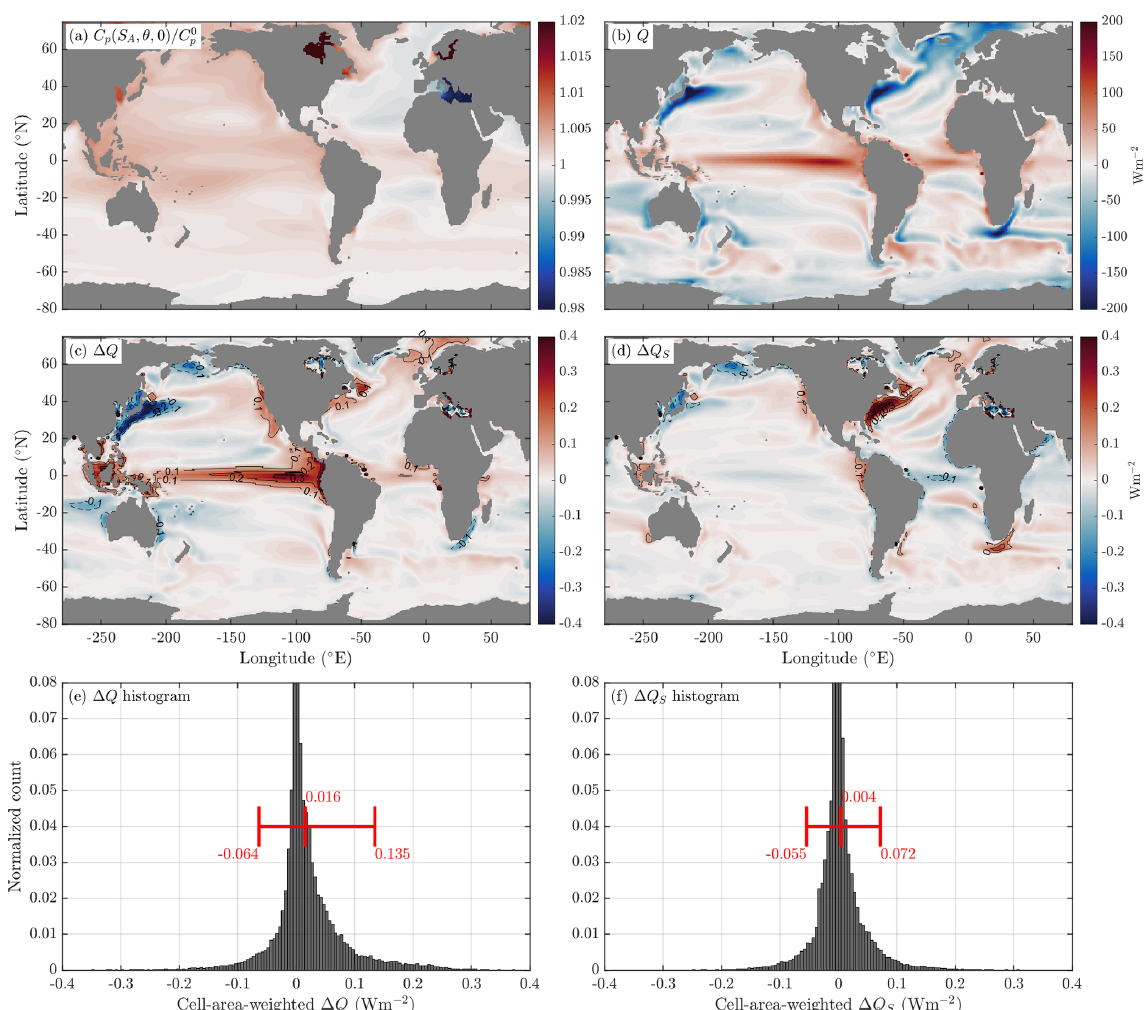
Figure 5. (a) The average value of the ratio of the isobaric specific heat of seawater and c 0 p for data from the ACCESS-CM2 model’s pre- industrial control simulation (600 years long). (b) The average surface heat flux Q (Wm − 2 ) in this same ocean model. (c) The additional heat that the ocean receives or loses compared to the heat that the atmosphere loses or receives (assuming that an EOS-80 model’s temperature variable is potential temperature), (cid:49)Q (Wm − 2 , Eq. 6). (e) A histogram of (cid:49)Q weighted by the area of each grid cell. (d) The contribution of salinity variations to the air–sea heat flux discrepancy given by (cid:49)Q S = Q(S − S)( 1 /c 0 p )∂c p /∂S , where S is the surface mean salinity and ∂c p /∂S is the variation in the specific heat with salinity at the surface mean salinity and potential temperature. (f) A histogram of (cid:49)Q S weighted by the area of each grid cell. Shown in red in panels (e) and (f) are the mean as well as the 5th and 95th percentiles of the histogram (Wm − 2 ). Note that these calculations neglect correlations between surface properties and the surface heat flux at sub-monthly